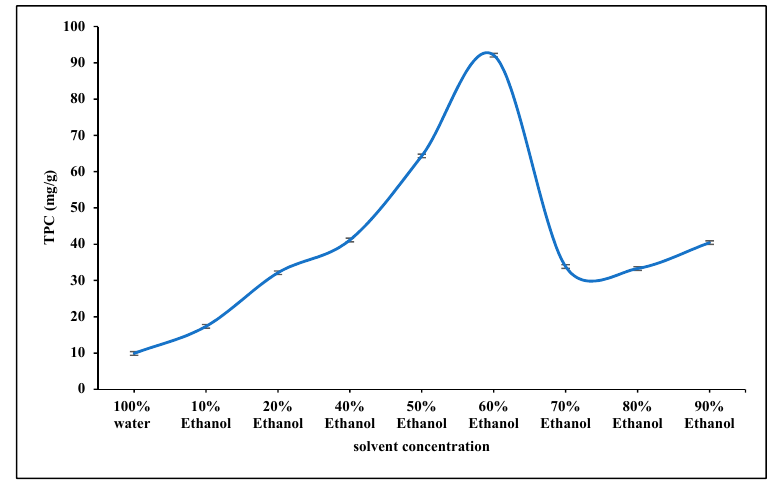
Figure 1. Effect of ethanol% on the TPC extraction from CJPD.